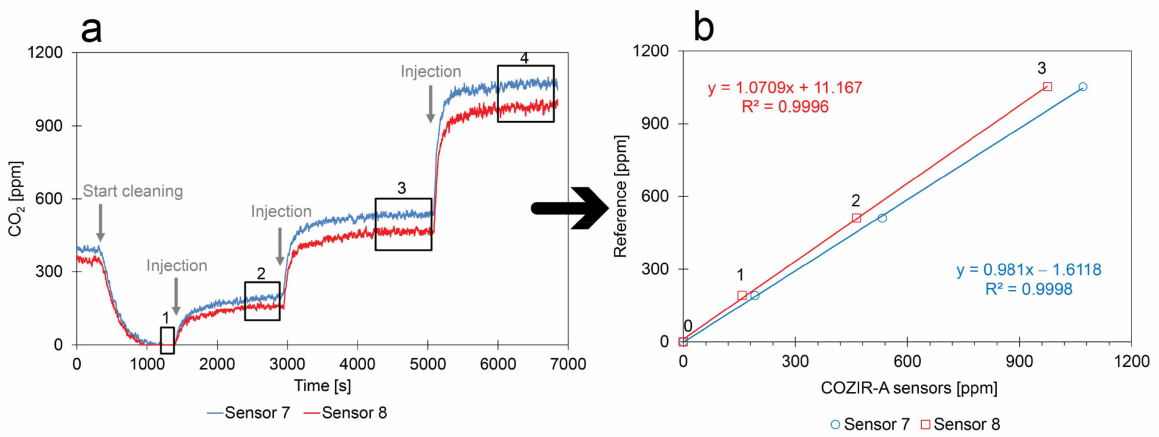
Figure 12. ( a ) Concentration trends of CO 2 during the calibration process for the two COZIR-A sensors performed in Cuba; ( b ) calibration curves obtained for CO 2